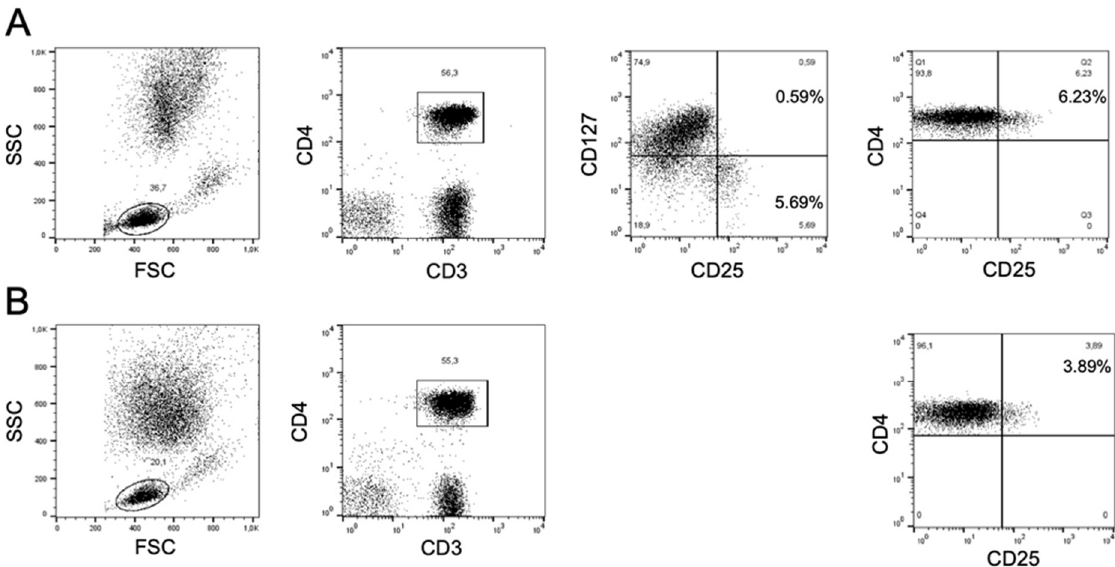
Figure 1. General gating strategy for the pairwise comparison of CD4 pos CD25 high in pre- and post- vaccination samples. ( A ) In this representative case, the post-vaccination sample is stained with antibodies to CD3, CD4, CD25 and CD127; electronically gated CD3 pos CD4 pos cells are analyzed for CD25 and CD127 expression and gates are set to define CD25 high CD127 low (5.69% of cells) and CD25 high CD127 pos (0.59% of cells) populations; the setting of the x -axis adopted for defining CD25 positive fluorescence (phycoerythrin) is then used to calculate the total fraction of CD4 pos CD25 high cells in this sample as well as ( B ) in the pre-vaccination sample in which CD127 staining was not done and CD25 was stained with the same phycoerythrin-conjugated antibody.